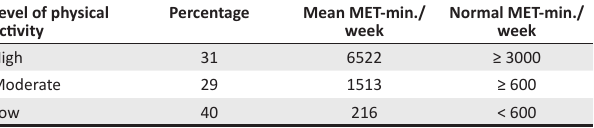
TABLE 2: Level of physical activity categories versus metabolic equivalent of